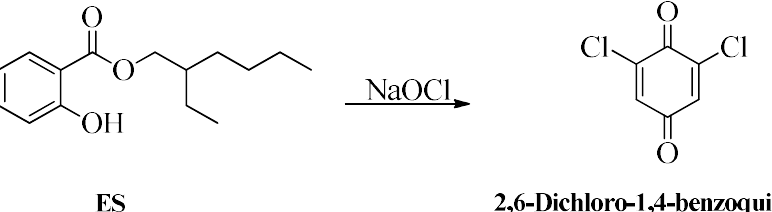
Figure 6. Disinfection by-products from ES chlorination.